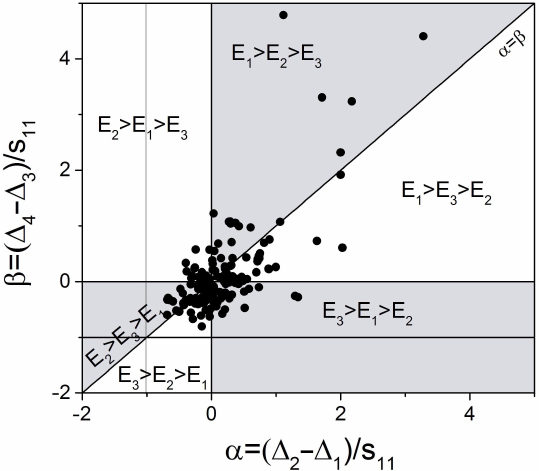
Figure 1. Classification scheme for stationary values of Young’s modulus ( E 1 , E 2 and E 3 ) for rhombic crystals. The points indicate the values of dimensionless parameters α and β for 142 rhombic crystals from [4].